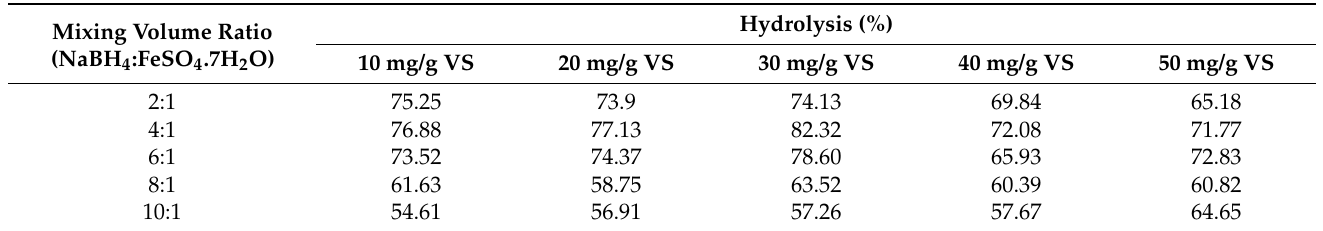
Figure 1. ( a ) Effect of NP-ZVI doses and various MVR on the concentration of SCOD after one day of the incubation period, where the SCOD concentration of the control test was 1.78 g/L; ( b ) Effect of NP-ZVI doses and various MVR on the concentration of SCOD after six days of the incubation period, at the same time the SCOD concentration of the control test was 2.5 g/L; ( c ) Effect of NP-ZVI doses and various MVR on the concentration of SCOD after 15 days of the incubation period, at the same time the SCOD concentration of the control test was 0.99 g/L. The hydrolysis percentage of various NP-ZVI doses and mixing volume ratios (NaBH 4 :FeSO 4 .7H 2